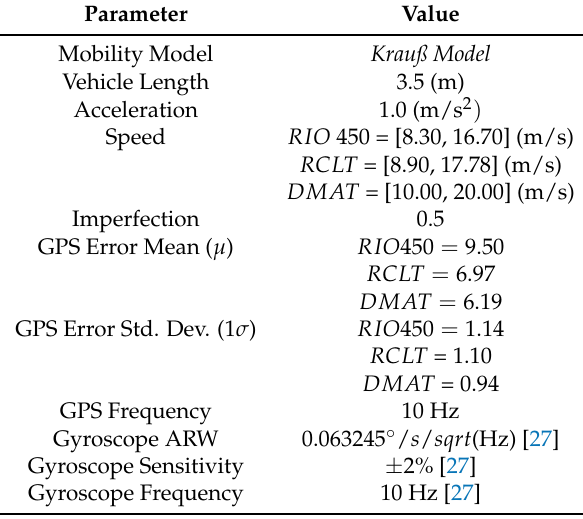
Table 4. Mobility parameters.